Question: From the figure, is the trend upward or downward?
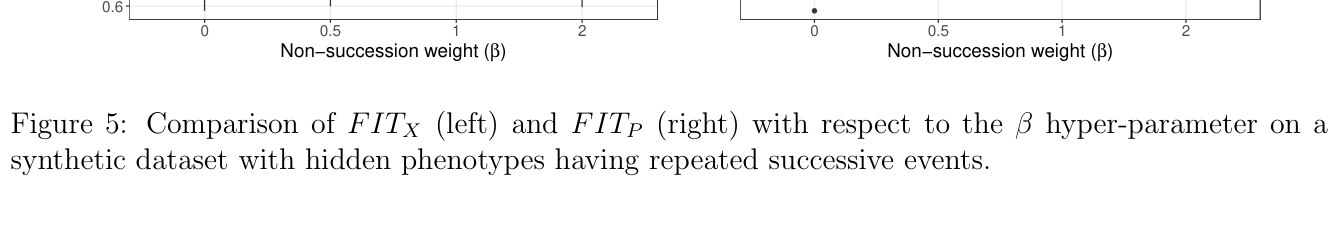
Answer: increasing